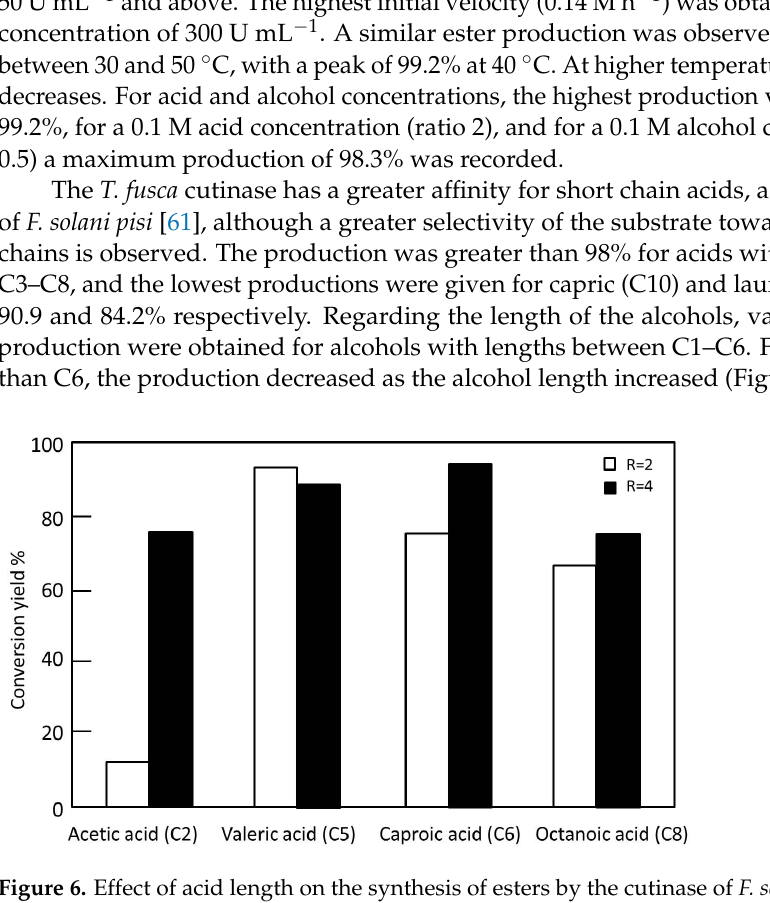
Figure 6. Effect of acid length on the synthesis of esters by the cutinase of F. solani pisi . White bars: alcohol: acid 2 ratio; black bars: ratio alcohol: acid 4. Image extracted from